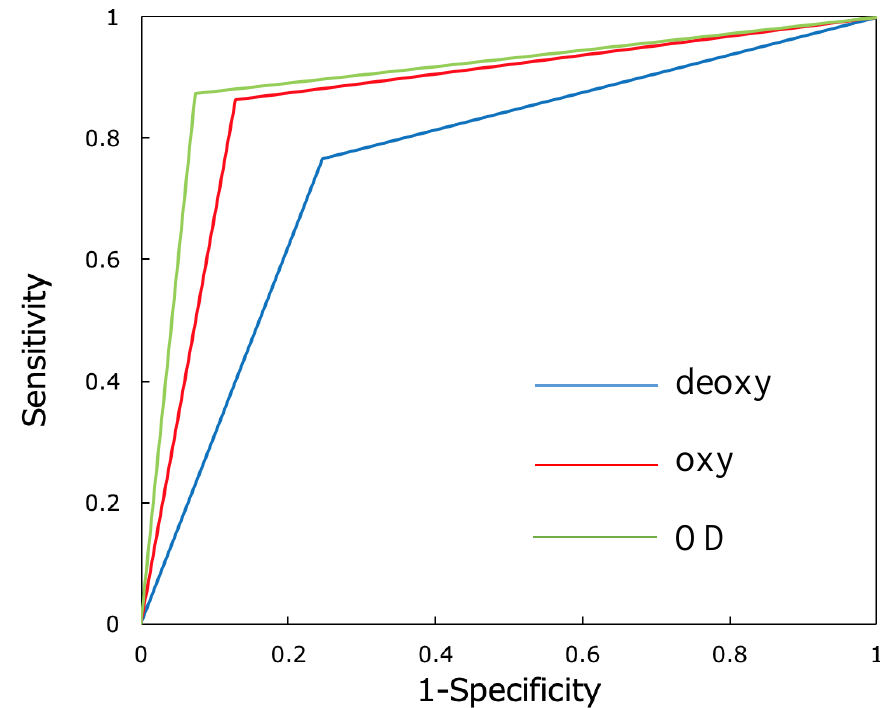
Figure 6. Receiver operating characteristic (ROC) curve comparison of the accuracy of the neural networks developed using oxy, deoxy, and OD images. The area under the ROC curve (AUC) related to deoxy images was 0.759 (95% confidence interval (CI): 0.750-0.769, p < 0.0001), that related to oxy images was 0.867 (95% CI: 0.861-0.874, p < 0.0001), and that related to OD images was 0.900 (95% CI: 0.893-0.907, p < 0.0001). Deoxy: ROC curve for deep learning (DL) using deoxy images (blue line). Oxy: ROC curve for DL using oxy images (red line). OD: ROC curve for DL using OD images (green